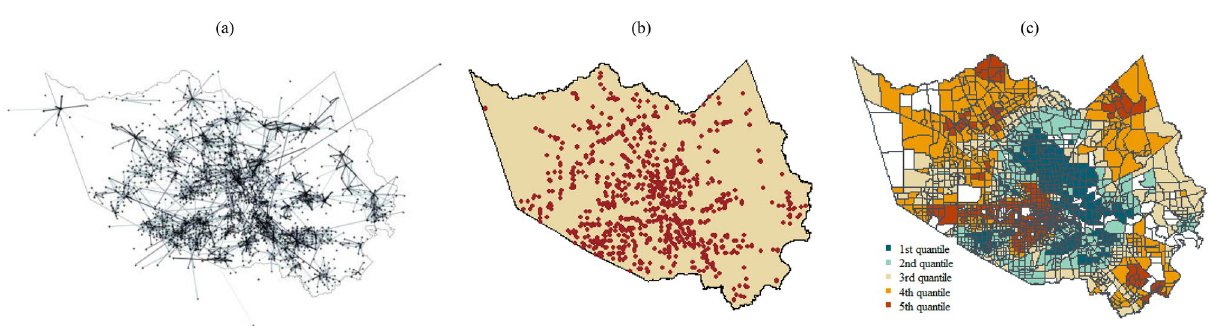
Figure 2. Distribution of the facilities and vulnerable population in Harris County. ( a ) network of trips from 1804 traffic analysis zones to 920 grocery stores containing 6052 links ( a ); location of grocery stores in Harris County ( b ); distribution of income levels in Harris County ( c ); income is categorized into five quantiles, with the 5th quantile indicating the highest income